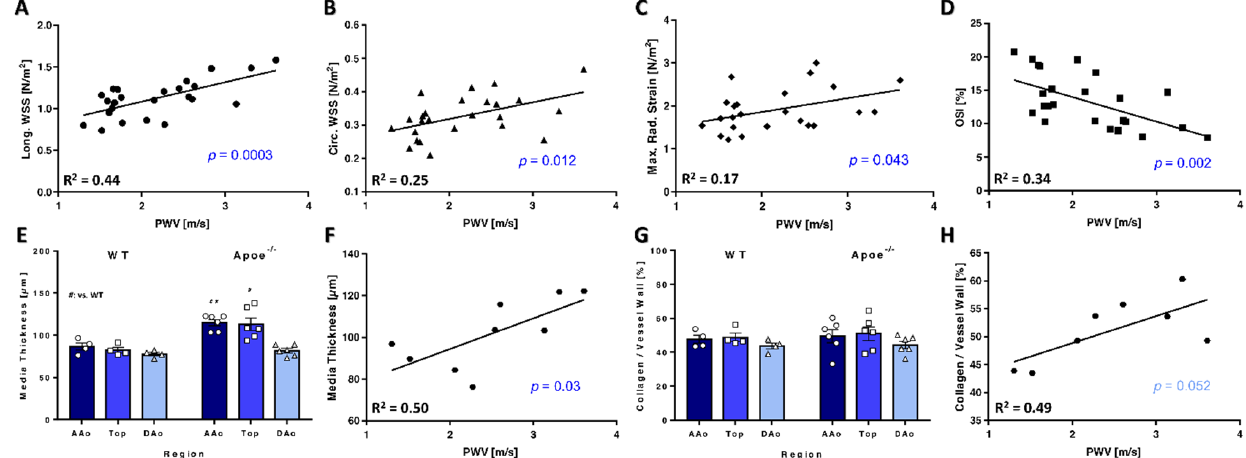
Figure 8. PWV correlates with WSS and vessel wall characteristics. ( A ) Correlation with longWSS. ( B ) Correlation with circWSS. ( C ) Correlation with maximum radStrain. ( D ) Correlation with OSI. ( E ) Media thickness: Significantly higher values were found in the AAo and top region of Apoe − / − compared with WT mice. ( F ) Correlation with media thickness. Media thickening increases PWV. ( G ) Collagen content of the vessel wall. No differences were observed. ( H ) Correlation with collagen content in the vessel wall. # vs. WT, p < 0.05; vs. WT, ## p < 0.01.